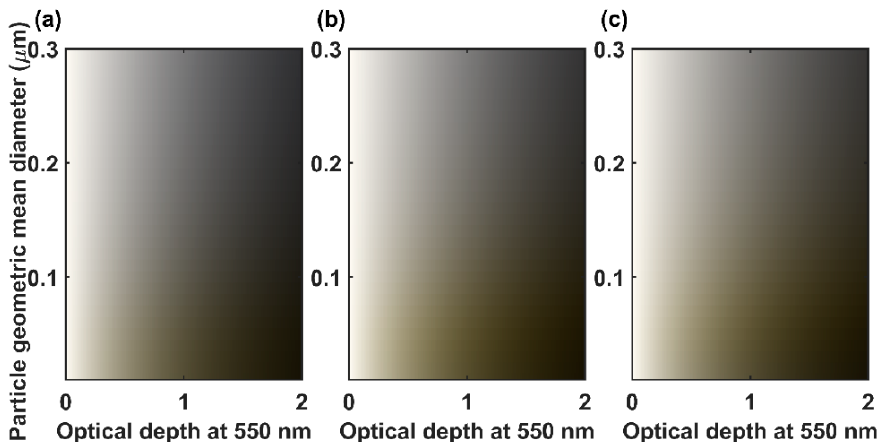
Figure 4. Three series of colors of BC aerosols with different optical depths and particle mean geometric diameters. The refractive indices used in the color simulations of ( a – c ) are from the studies of Schnaiter et al. [38], Chang and Charalampopoulos [25], and D’Almeida et al. [39].